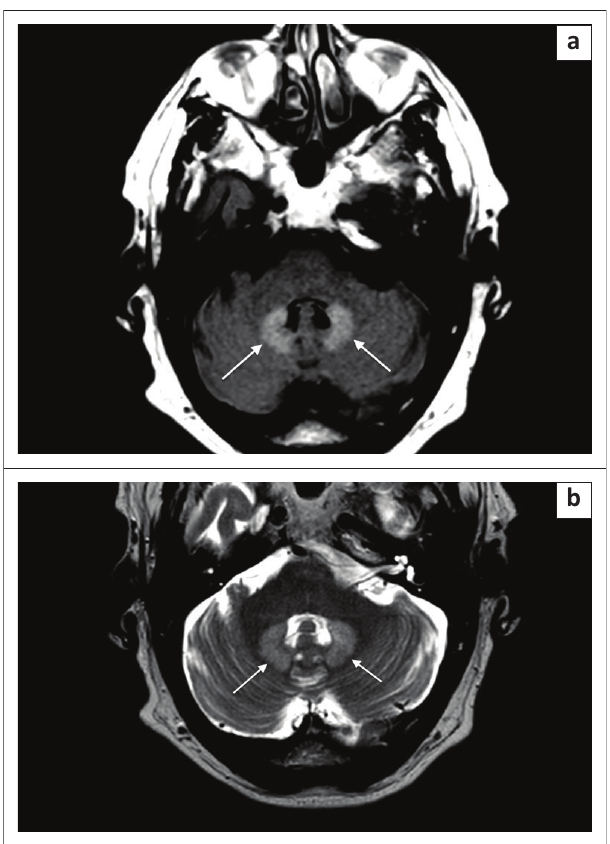
FIGURE 1: Fluid attenuated inversion recovery (a) and T2 turbospin echo sequence (b) demonstrating high signal intensity in the dentate nuclei bilaterally (white arrows).